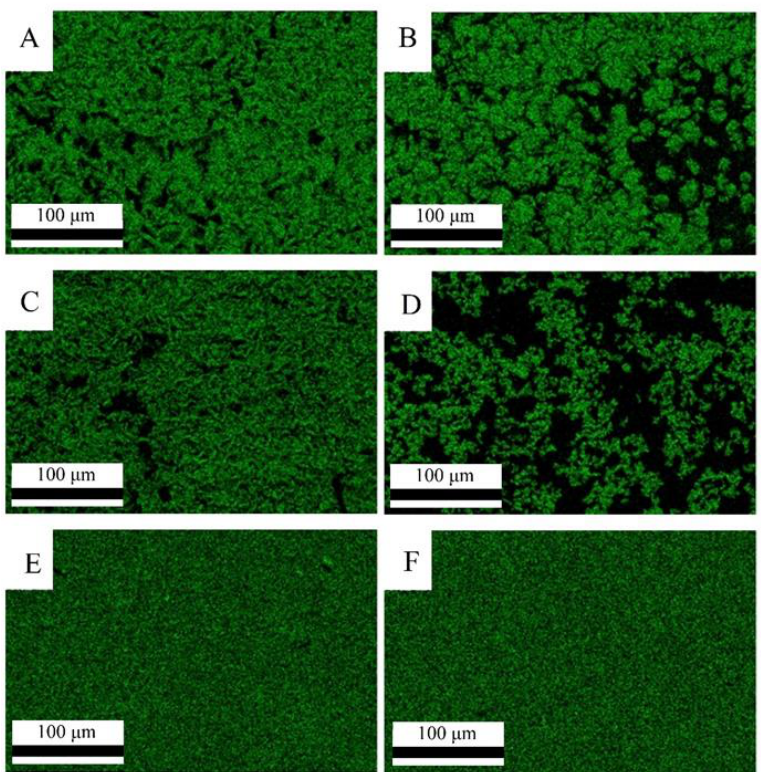
Figure 5. The distribution of phosphor atoms on the surface of the samples: AL1-N ( A ), AL1-NG ( B ),